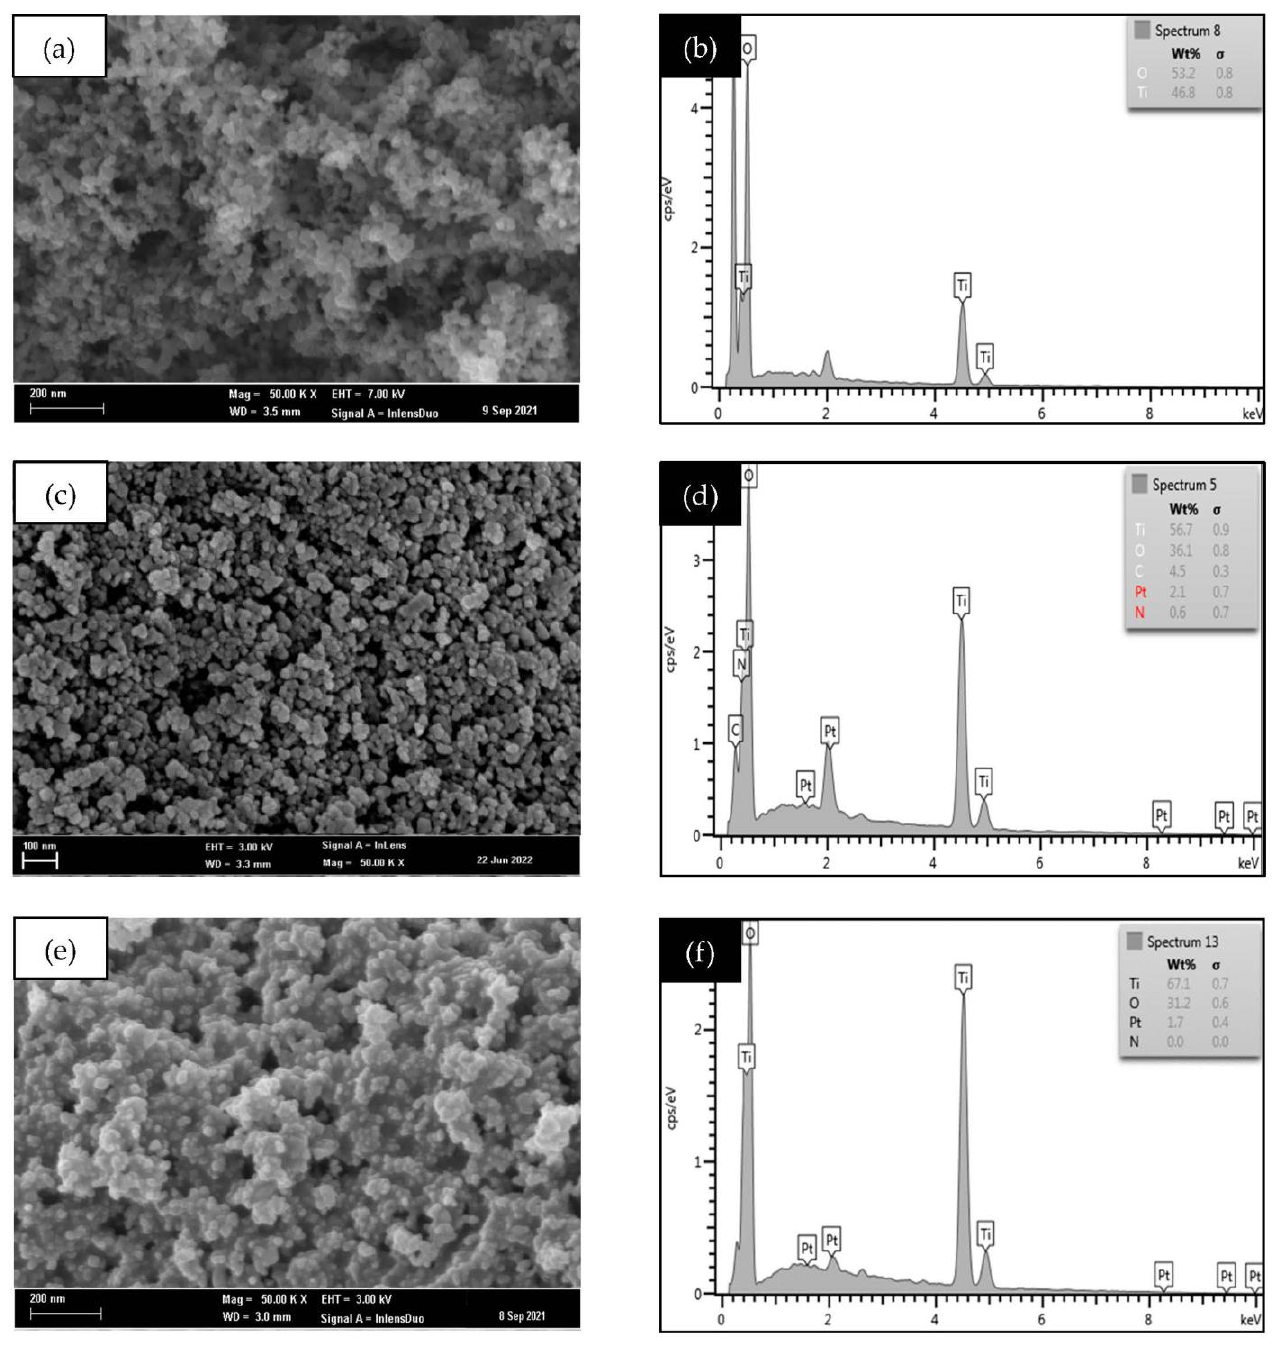
Figure 5. The morphology and EDX analysis for ( a , b ) TiO 2 , ( c , d ) NP seq -TiO 2 , and ( e , f ) PN rev -TiO 2 photocatalysts.